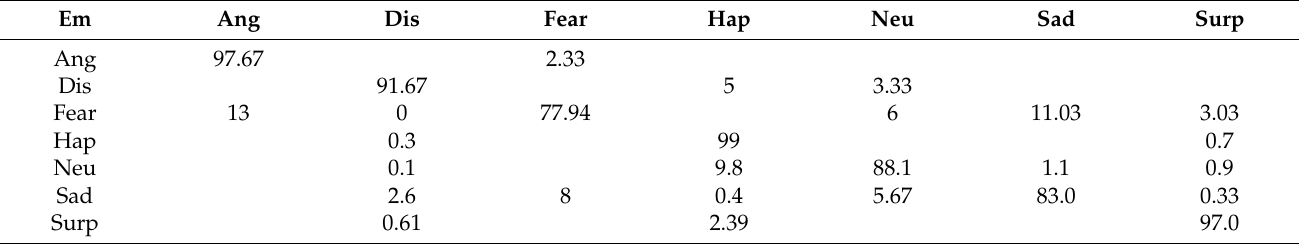
Table 6. Matrix representing the confusions in Oulu-CASIA